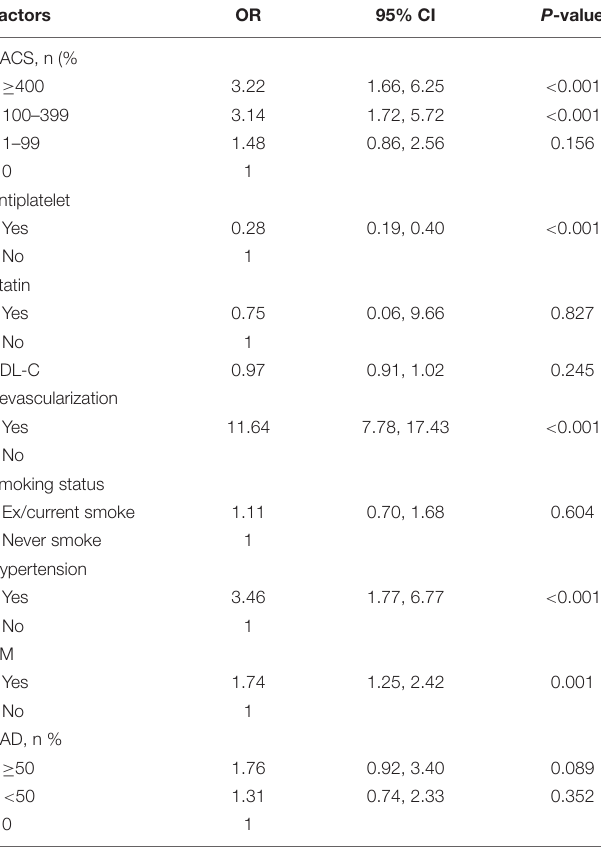
TABLE 3 | Factors associated with receiving antiplatelet treatment and MI occurrence: a multivariate GSEM. Factor